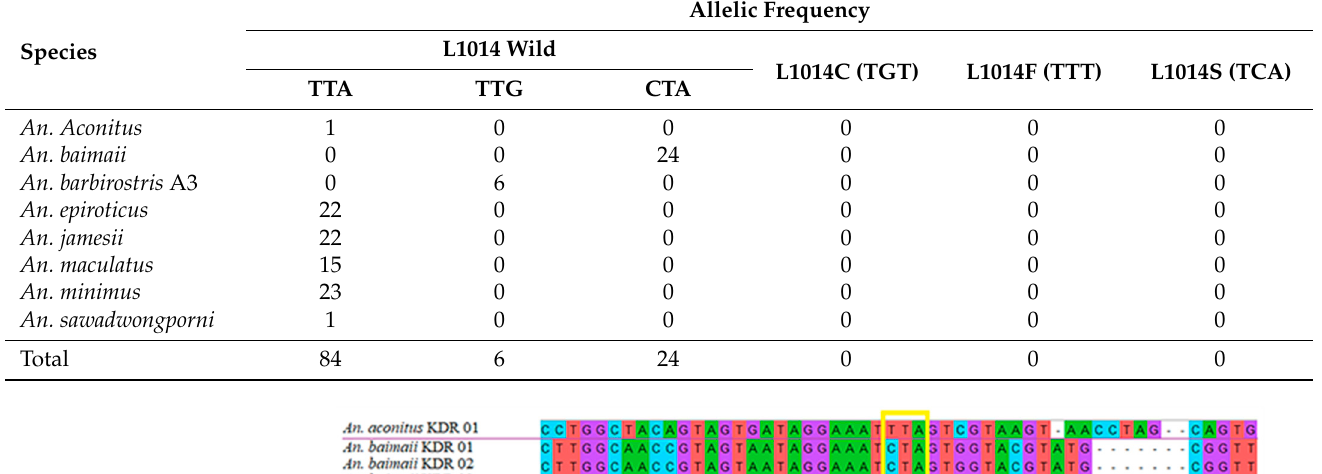
Table 5. Screening for kdr mutations in the voltage-gated sodium channel ( VGSC ) gene in specimens of eight Anopheles species obtained in this study.